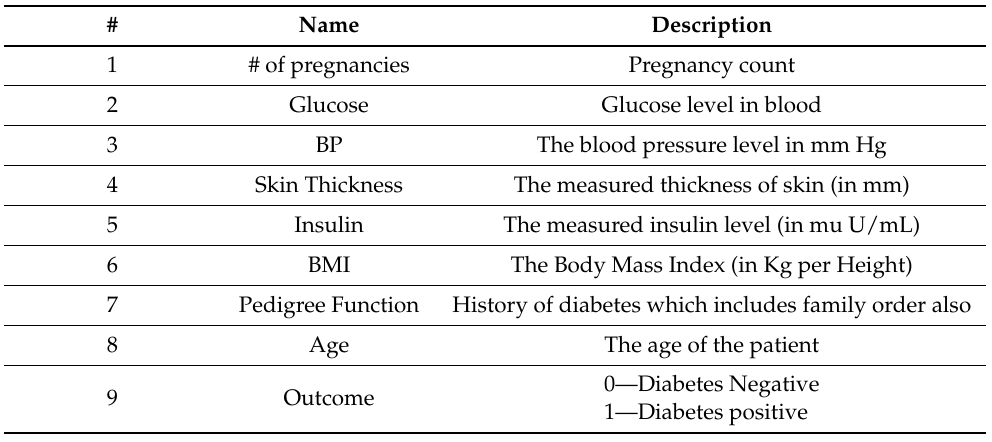
Table 2. Dataset Description.